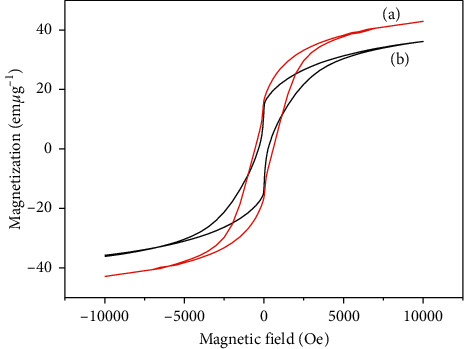
Magnetic hysteresis curves of CoFe2O4 (a) and CoFe2O4@SiO2 (b).